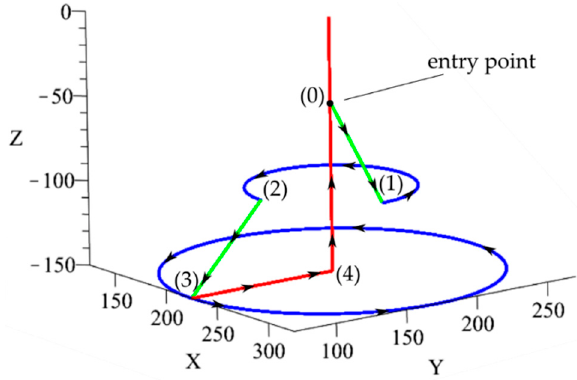
Figure 5. A simulated trajectory for the tip of the US probe. In order to compute the inverse kinematics of the PRO-HEP-LCT with respect to the trajectory previously defined, the mathematical conditions for the Cartesian coordinates of the mobile coordinate frame and the orientations were substituted in the kinematic models derived in Section 3. The trajectory between the points (1) and (2) is defined by a three quarters of a circle with 50 mm radius, whereas the trajectory starting (and ending) at point (3) is a full circle with 100 mm radius. The velocity for the linear insertion of the US probe was set to 20 mm / s and a maximum (absolute value) of 50 mm / s for the probe retraction; the velocity of the probe tip while guided on the curve from the point (1) to the point (2) was 12 mm / s, and the velocity of the probe tip while guided on the curve from the point (3) back to the point (3) was 32 mm / s. Figure 6 presents the results for the actuated joints (displacement, velocity, and acceleration). It is worth noting that no input profiles for the actuators velocities (triangle or trapezoidal profiles) were used in the computation. Although implementing these profiles is necessary for the development of the control system, the numerical results that are provided in this section are mainly used to validate the analytical models derived in previous